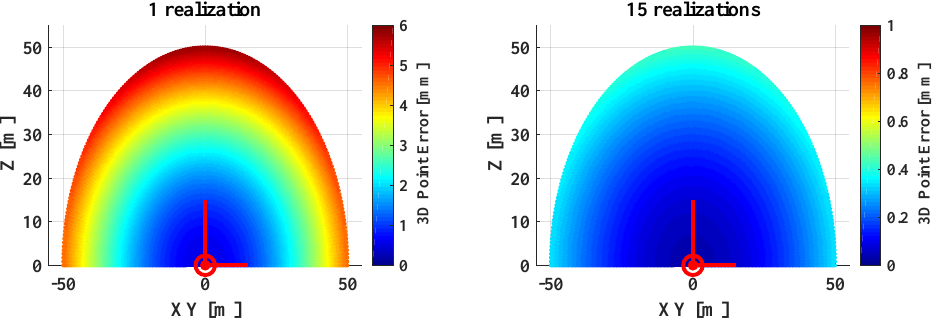
Figure 11. Additional uncertainty σ add of the mobile point cloud due to the uncertainty of the calibration 3 D parameters for a single calibration run ( left ) and 15 calibration runs ( right ), cf. Table 3.